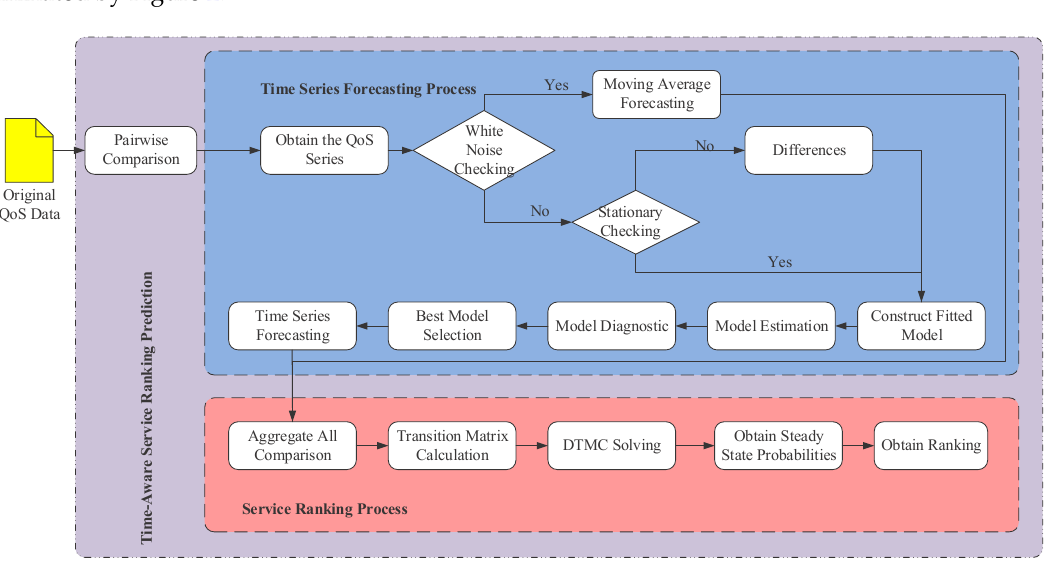
Figure 2. Framework of service ranking prediction. QoS: quality of service; DTMC: discrete-time Markov